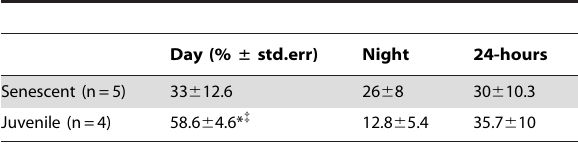
Table 1. Quiescence in adult/senescent and juvenile Sepia officinalis